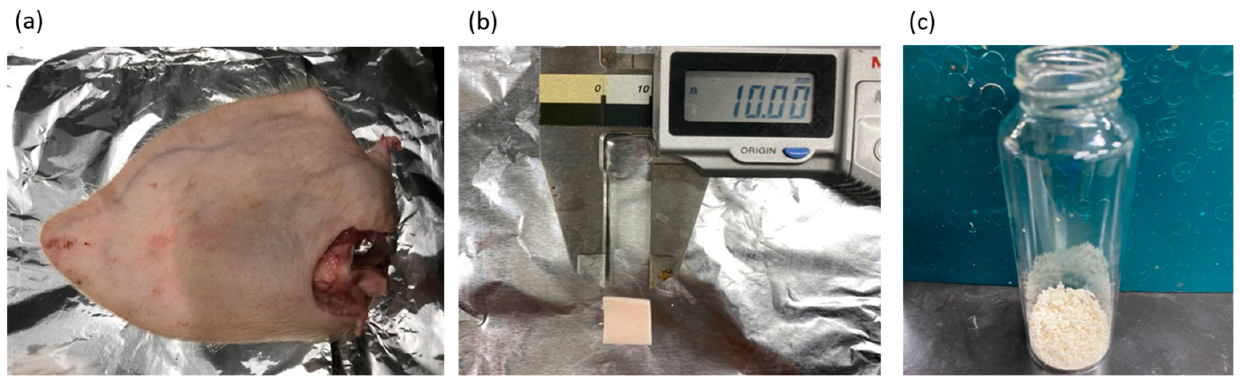
Figure 2. ( a ) Pig ear before removing auricular cartilage, ( b ) 10 × 10 × 1 mm sample, ( c ) 710–1000 µm-sized